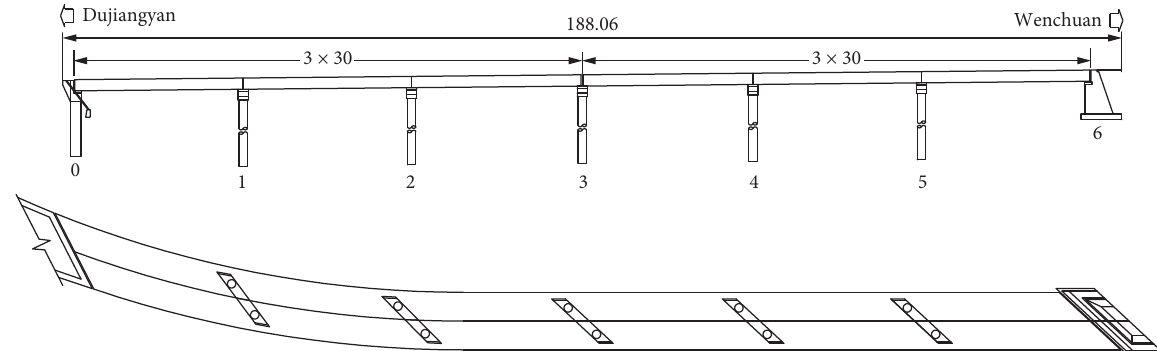
Figure 2: Elevation and plan view of Duxiufeng Bridge (unit: m).